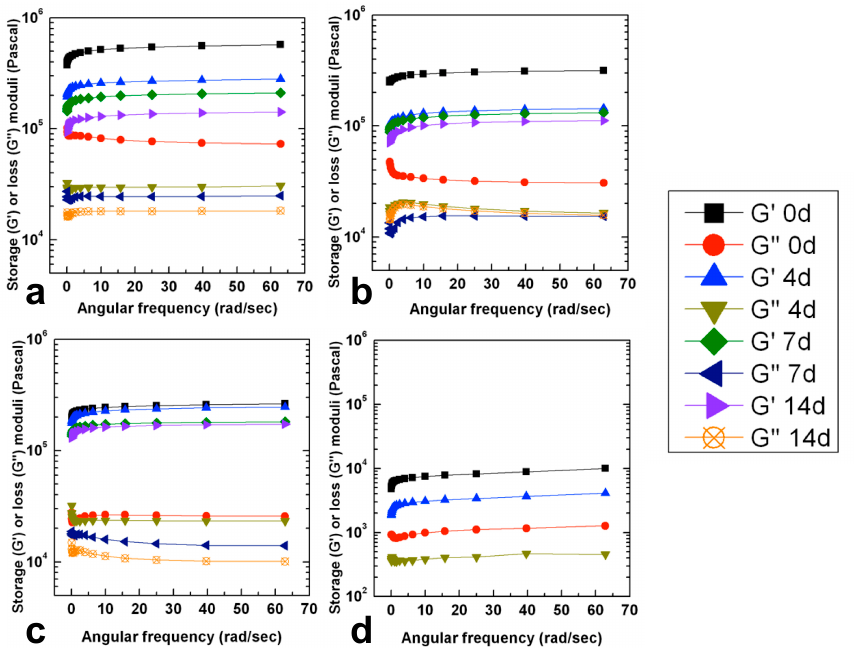
Figure 7. Frequency sweep rheograms performed at 1% of strain for GG 4 ( a ), GG 6 ( b ), GG 8 ( c ) and GG 24 ( d ) ionotropic crosslinked hydrogels incubated for different times in DPBS pH 7.4 at 37 °C.